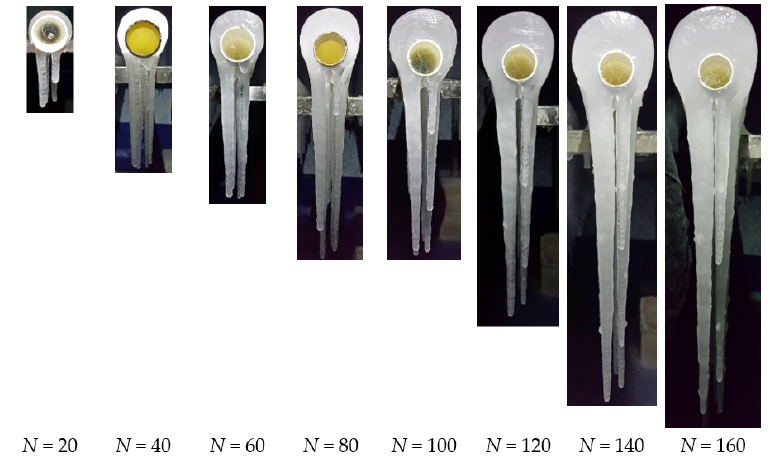
Figure 8. Profiles of ice accretions for various N ( D = 25 mm).